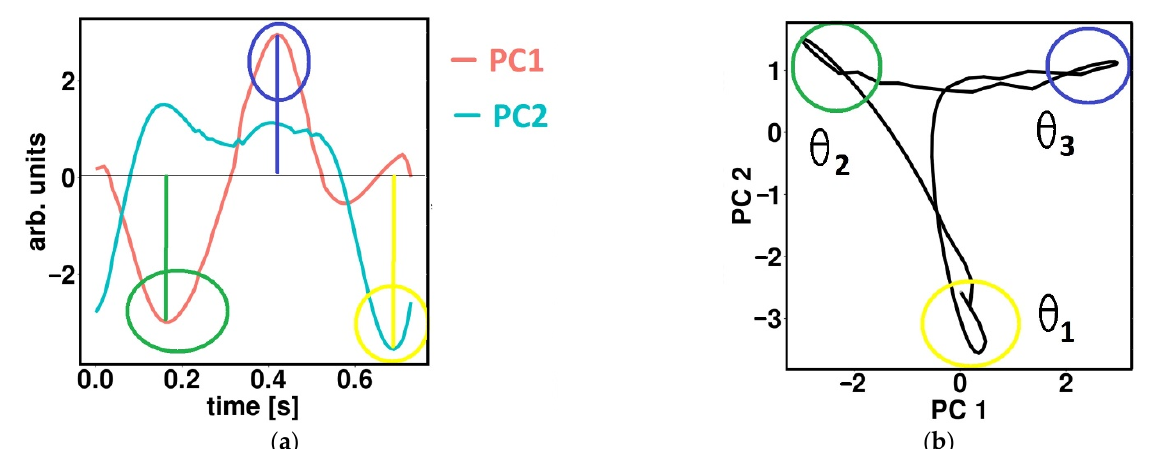
Figure 4. Representation of temporal synergies on the first two components on: ( a ) time PC signals; ( b ) PCA gait cyclograms. Time activations of temporal synergies are displayed using different colors (green, blue, yellow).